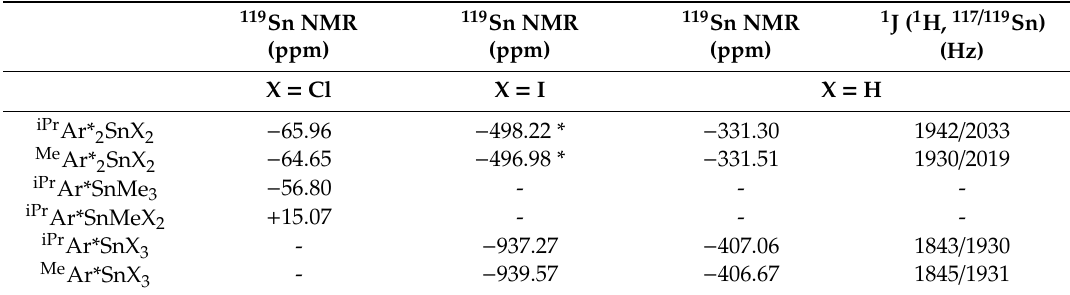
Table 1. Sn NMR shifts (ppm) of aryltin compounds and 119 Sn NMR shifts (ppm) and coupling constants (Hz) of isolated aryltin